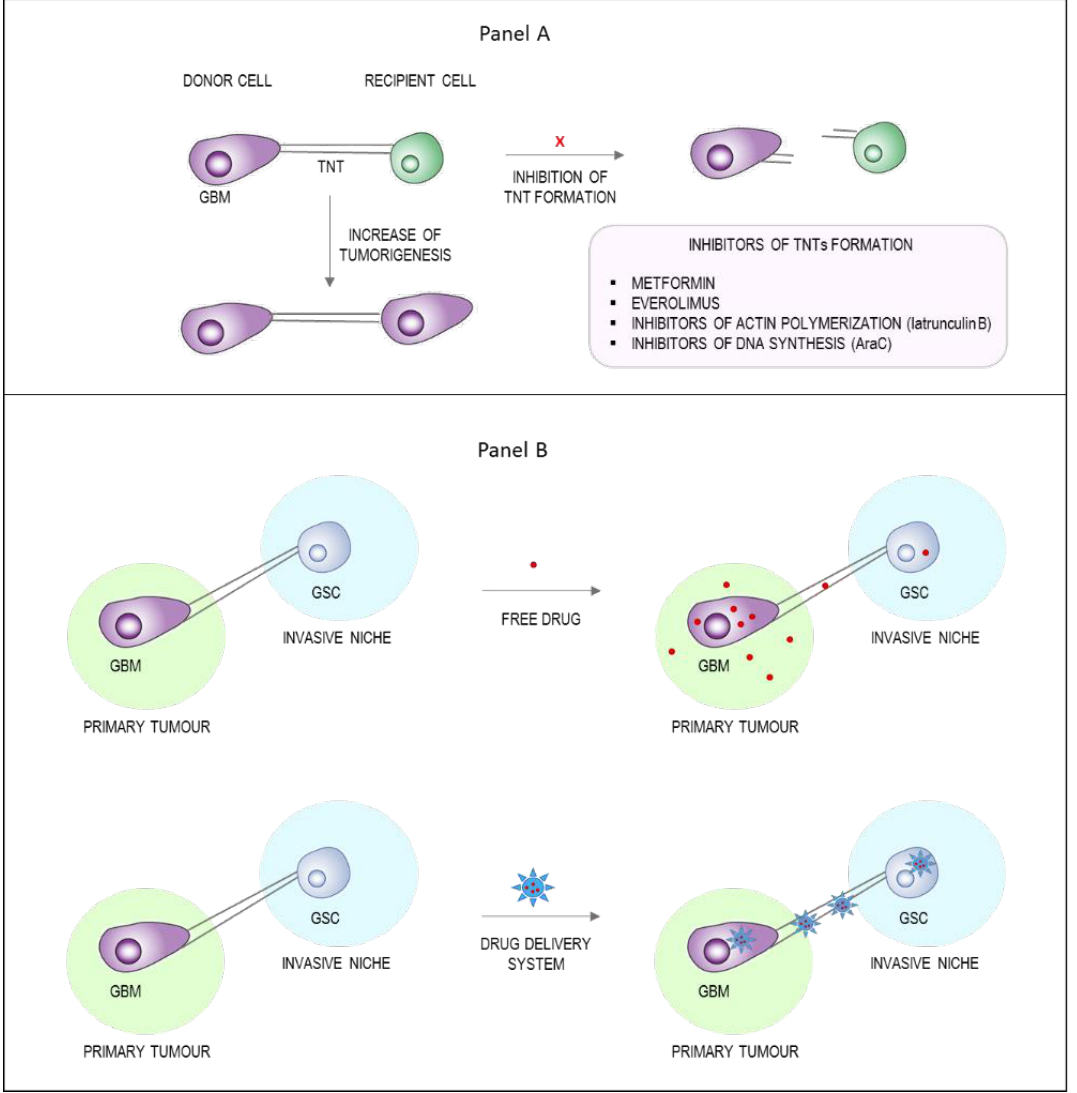
Figure 3. Potential therapeutic approaches based on TNTs. TNTs have been observed in several types of cancer, where they emerge to steer a more malignant phenotype thanks to the exchange of intracellular materials. ( A ) The design of molecules able to inhibit the formation of TNTs (i.e., inhibitors of actin polymerization, inhibitors of DNA synthesis, or inhibitors of mTOR pathway) may be a new therapeutic opportunity. ( B ) Since TNTs are long membrane nanotubes connecting distant cells, they can represent an exciting opportunity to deliver drugs or drug delivery systems in order to target inaccessible brain regions where GSCs are hidden and unreachable. Abbreviations: TNTs, tunneling nanotubes; GSCs, glioblastoma stem cells; GBM,